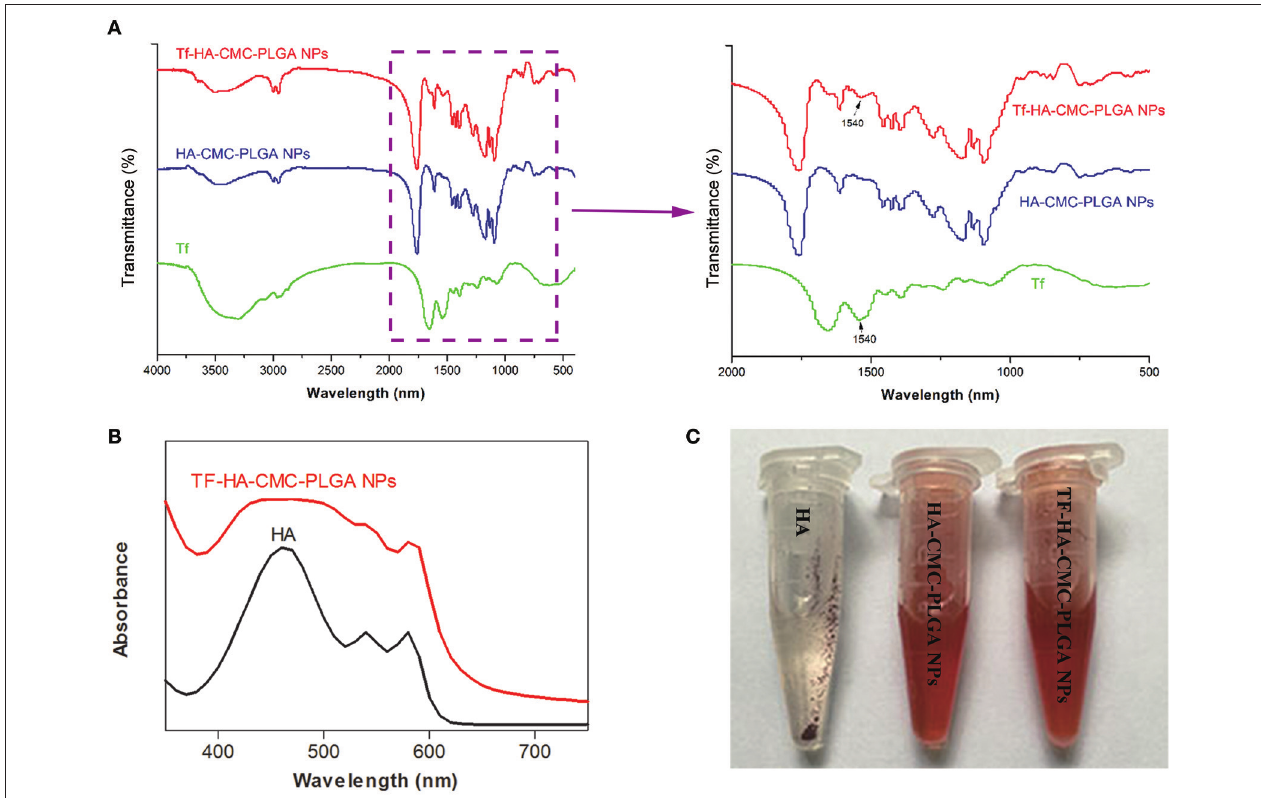
FIGURE 4 | Physicochemical properties of TF-HA-CMC-PLGA NPs. (A) FT-IR spectra and magnification FT-IR spectra of TF, HA-CMC-PLGA NPs, and TF-HA-CMC-PLGA NPs; (B) UV-vis spectra of HA in acetone and TF-CMCS-PLGA-HA in aqueous solution; (C) Water-solubility characterization of HA, HA-CMC-PLGA NPs, and TF-HA-CMC-PLGA